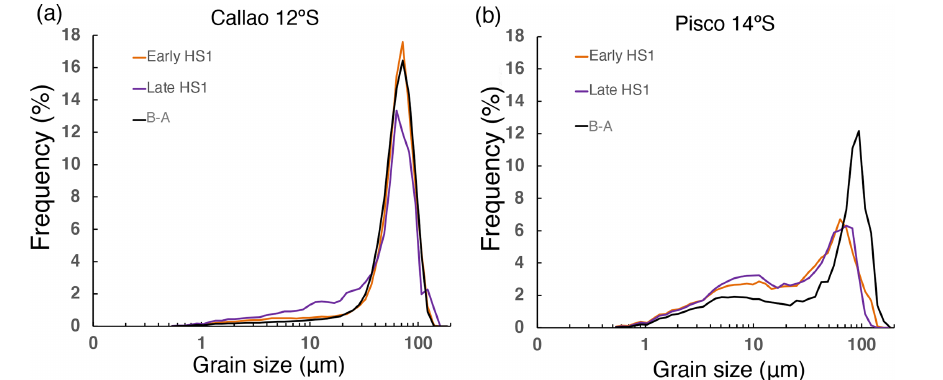
Figure 3. Mean grain-size distribution by climatic period in Callao (a) and Pisco (b)